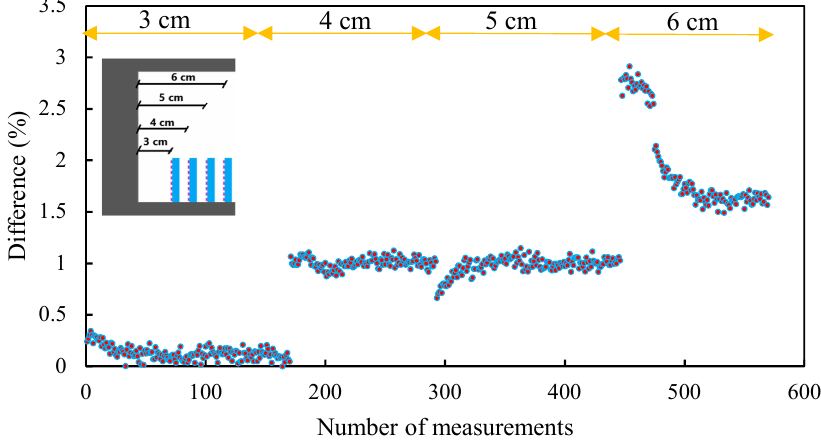
Figure 10. Sensitivity analysis of the HEAT MLX90614.